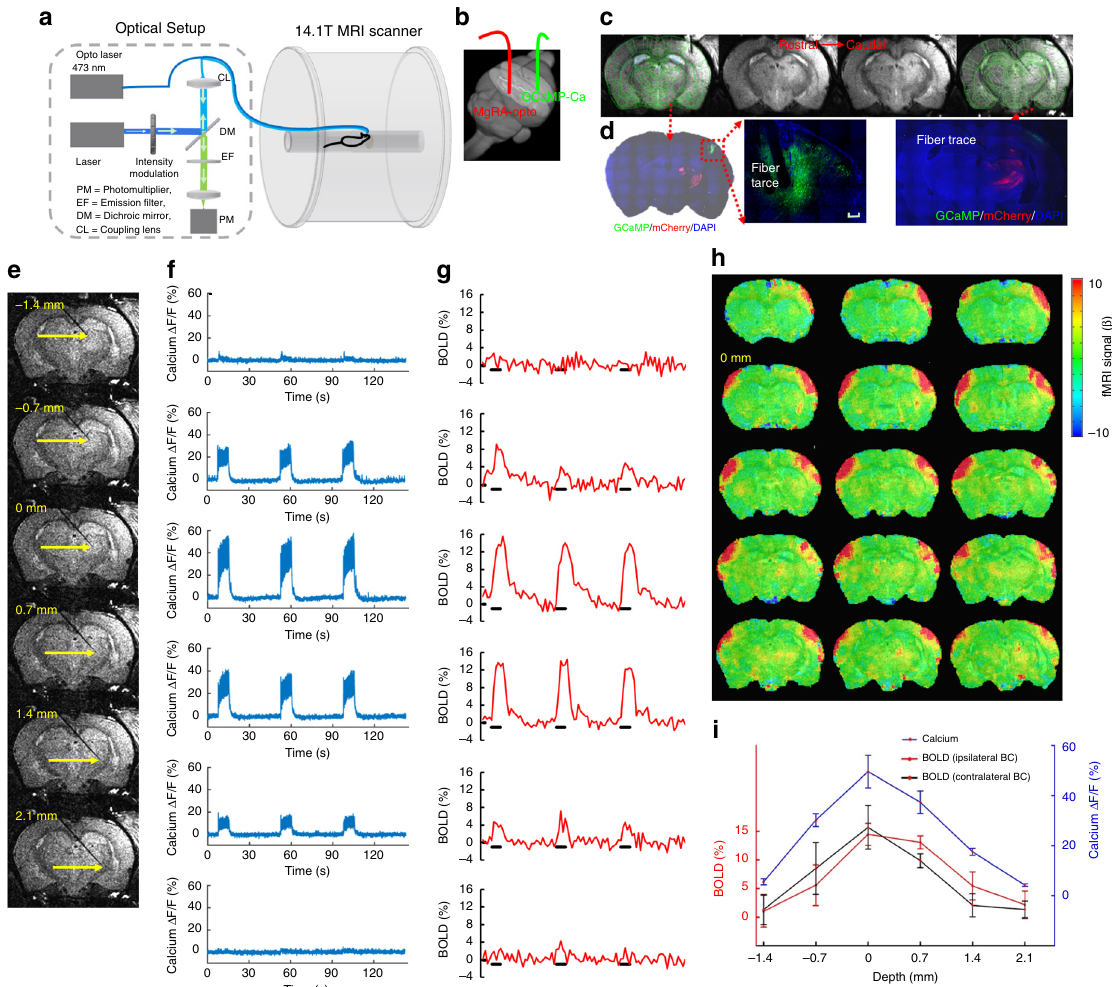
Fig. 4 MgRA-driven stepwise optogenetic activation of the thalamic nuclei with simultaneous fMRI and neuronal Ca 2 + recordings. a Schematic drawing of the experimental setup to conduct optogenetic fMRI with simultaneous fi ber optic calcium recording. The optical setup was placed outside the 14.1 T scanner. Opto Laser: laser for optogenetics. b Schematic of the fi ber optic insertion inside the rat brain (3D view) with MgRA-controlled optical fi ber for optogenetic activation (red) and a second optical fi ber for calcium recording (green) in the barrel cortex. c The anatomical MRI images con fi rm the location of the recording fi ber and the stimulation fi ber targeting the VPM thalamic region. The brain atlas is superimposed on the anatomical image (green). d The immunostaining images show the ChR2 expression in the thalamic region (ChR2-mCherry marked in red), as well as the GCaMP6f expression (green) in the vibrissal S1 cortical neurons (BC) with the fi ber trace. Scale bar, 200 µ m. e Anatomical RARE MR images illustrate the fi ber tip location at 6 steps, at a step-size of 700 μ m. f Percentage changes of the evoked calcium signal for 3 epochs upon light stimulation (3 Hz, 10 ms pulse width, 3.7 mW laser power, 8 s on 37 s off block design). g Simultaneous BOLD signals for 3 epochs within the ipsilateral somatosensory cortex (see (h)). h Evoked BOLD fMRI map when the fi ber tip was positioned at 0 mm along the insertion trajectory (zero considered as the position that leads to the peak fMRI and calcium signals). i Average amplitudes of the ipsilateral evoked calcium and BOLD signals of both hemispheres as a function of the fi ber tip locations. Error bars